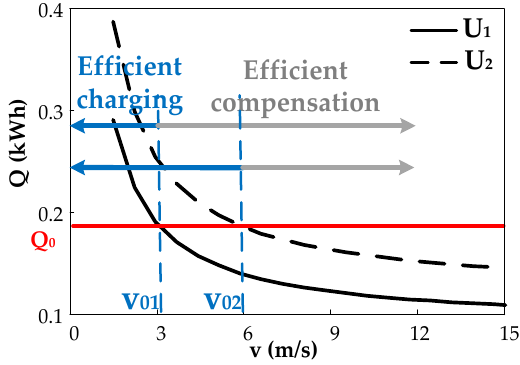
Figure 6. Charging energy of each EV according to driving speeds per km.